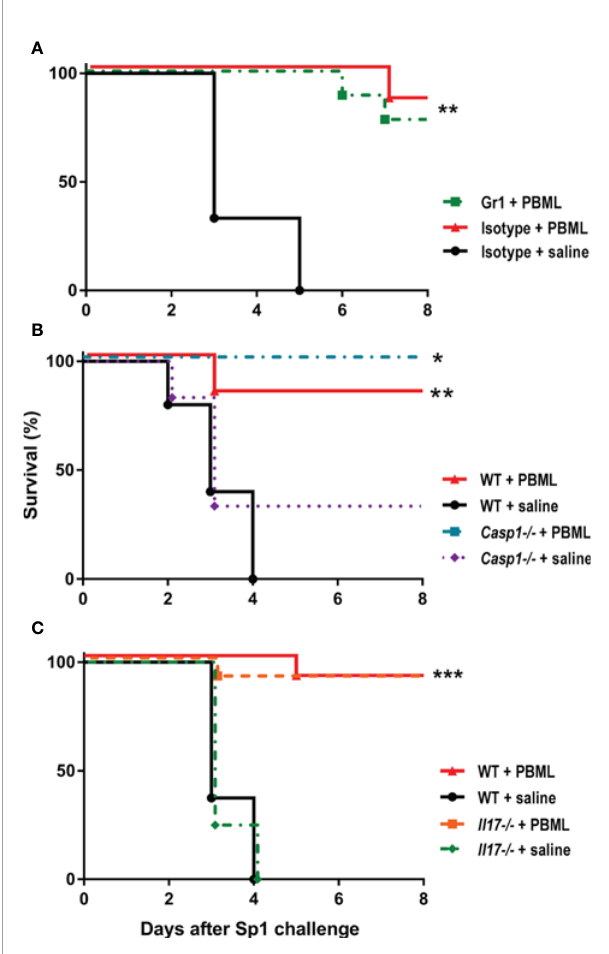
FIGURE 6 | (A) Survival rates after Streptococcus pneumoniae (Sp1) challenge of mice that were depleted from PMNs. Mice received Gr-1 or isotype control antibodies (i.p.) 12 h before being treated i.n. with PMBL lysate. All mice were challenged 24 h later with the MLD of Sp1 (3x10 6 CFU/50 µl). (B) Survival rates of Casp1 and wild-type mice (littermate of Casp1 ) n=6, challenged with Sp1 24 h after treatment with PMBL (18µg/30 µl) or saline. (C) Il17a-/- and wild-type mice n=6 were challenged i.n. with Sp1 24 h after treatment with PMBL (18µg/ 30 µl) or saline. Survival rates were recorded for 8 days for each group (n=6). Signi fi cant differences are shown by *p < 0.01, ** p < 0.001, ***p < 0.0001 treated vs. untreated, Log-rank test (Mantel-Cox). Data are representative of three independent